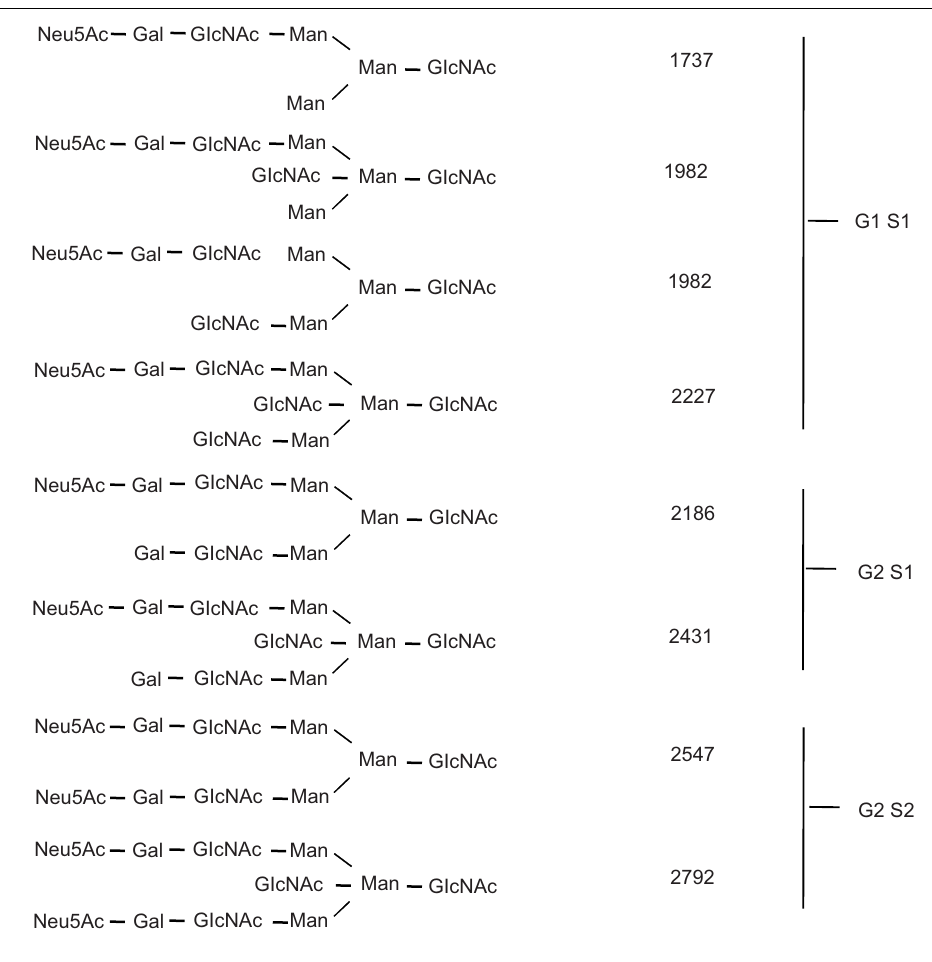
Supplementary figure 2. EndoS-released glycan structures. ( A ) The biantennary IgG Fc glycan core structure, which is coupled to Asn 297 consists of two N-acetyl-glucosamines (GlcNAc; dark blue) and three mannoses (Man), which can be further decorated with fucose; bisecting GlcNAc (light blue) and terminal GlcNAc (dark blue), galactose (G, Gal) and sialic acid (N-acetylneuraminic acid (Neu5Ac), S, Sial). The cleavage site of EndoS is indicated by an arrow. ( B ) The molecular mass (m/z) of the possible Fc glycan structures (permethylated) released from Asn 297 upon EndoS